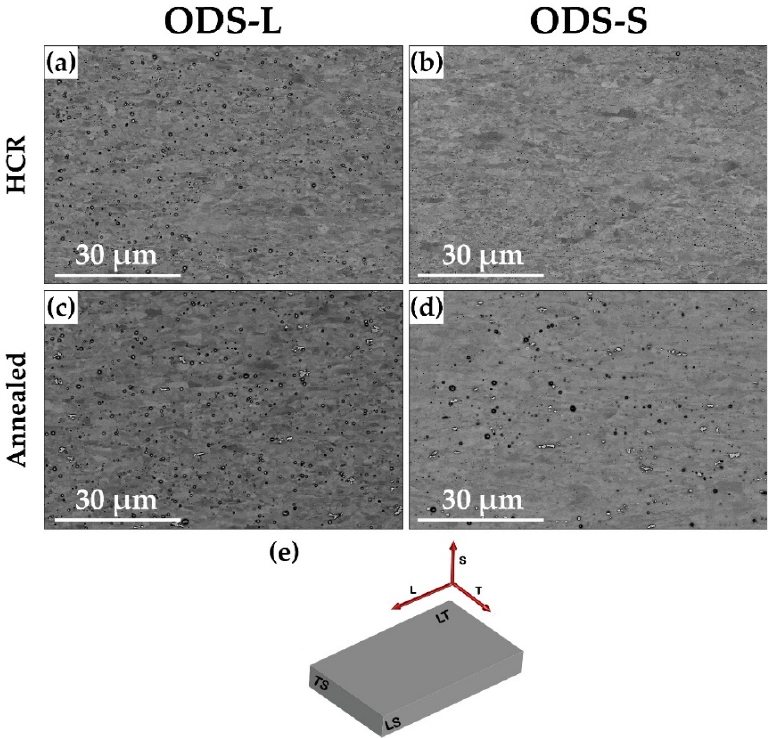
Figure 3. BSE SEM images with low magnification showing the microstructure of the ODS steels on the TS plane after HCR and after annealing at 1273 K. ( a ) ODS-L and ( b ) ODS-S steels after HCR; ( c ) ODS-L and ( d ) ODS-S steels and after annealing at 1273 K; ( e ) plane orientation